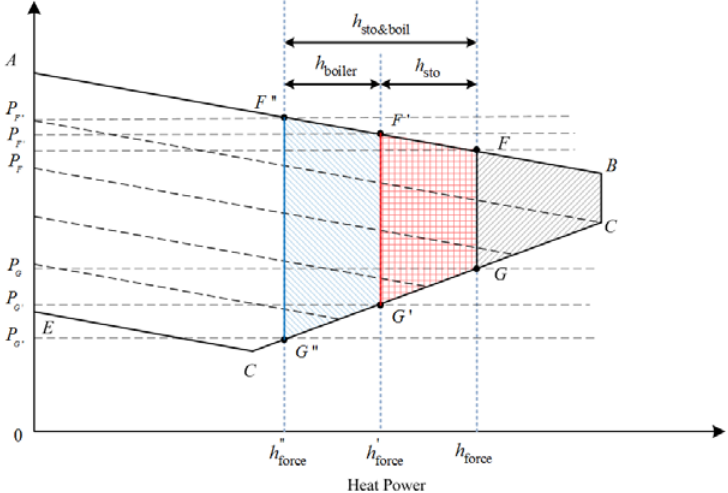
Figure 4. The effects of thermal-electric decoupling on the extraction turbo-generator